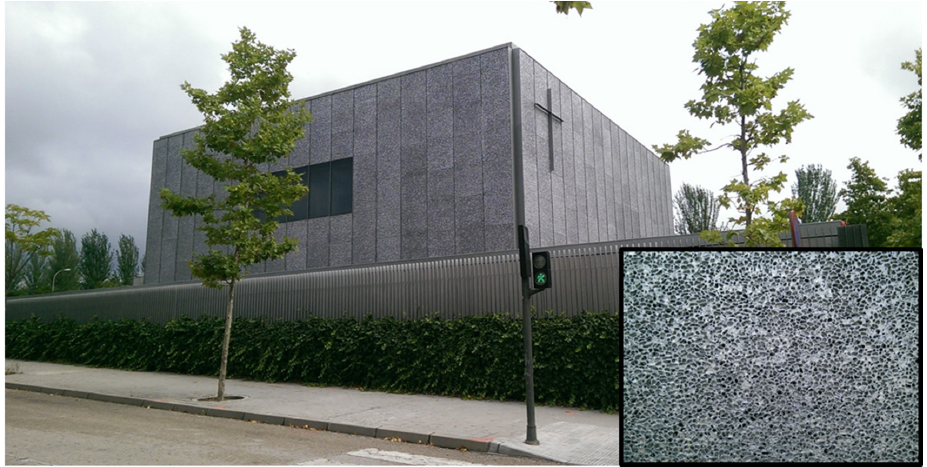
Figure 15. Protestant church in Terrasa, Spain, clad with Alusion foam. The inset shows a detailed view of the foam structure (courtesy of John Banhart).